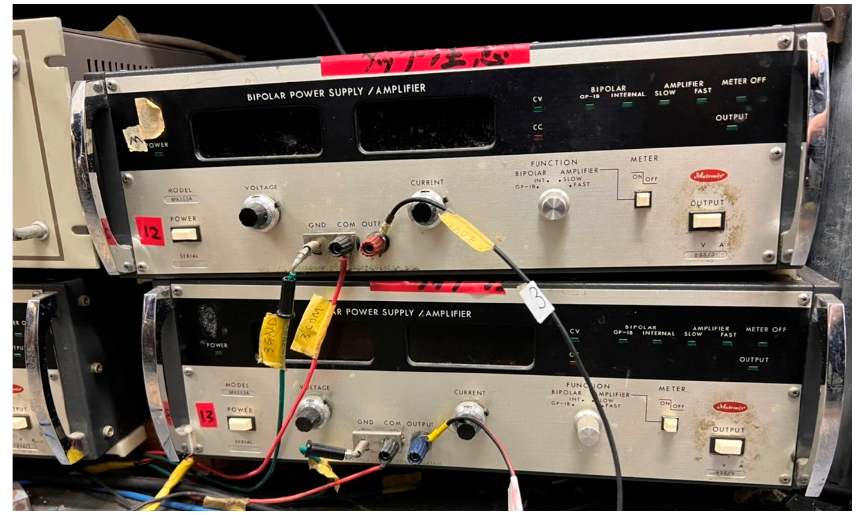
Figure 10. Photograph of the amplifier.